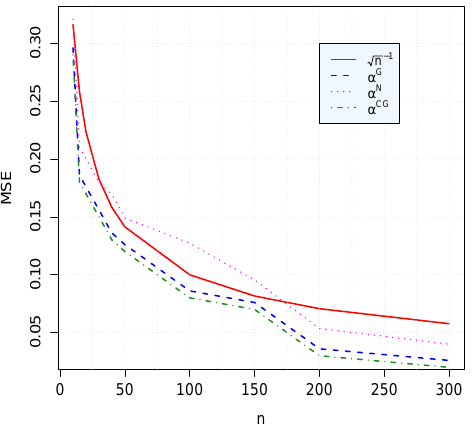
Figure 6. The MSE of ˆ α computed with Newton’s, gradient and conjugate gradient methods.